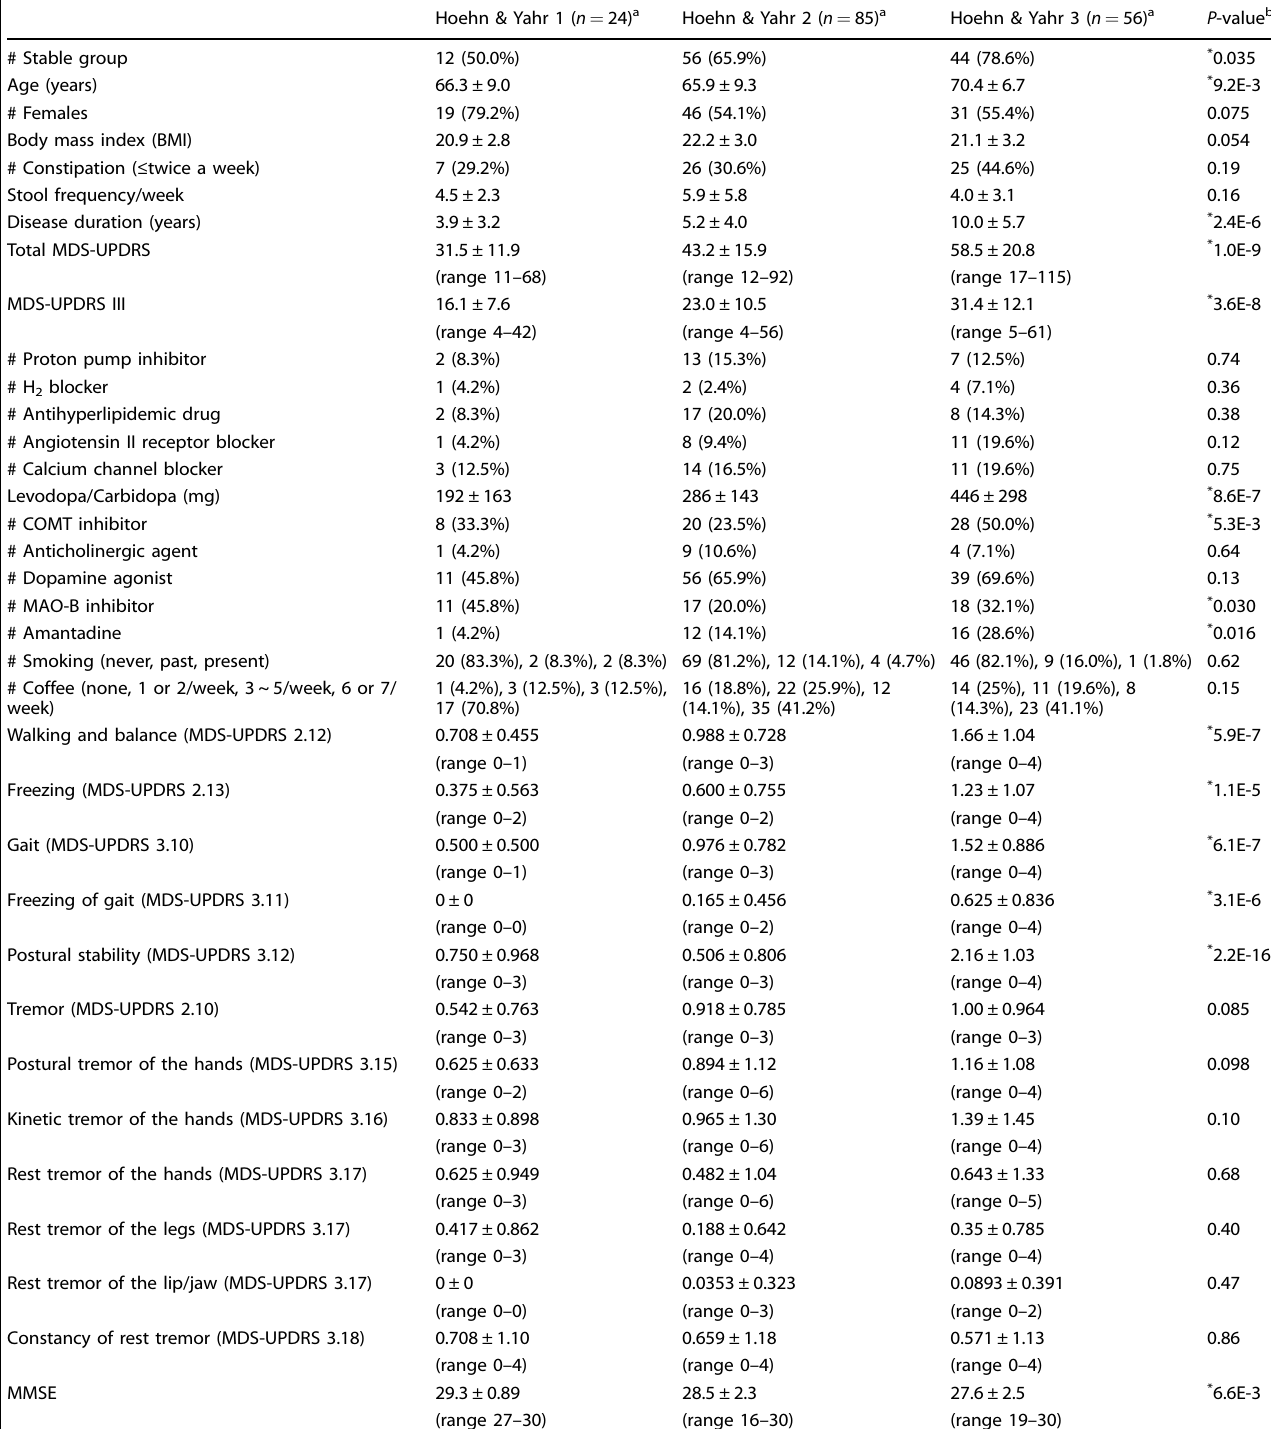
Table 1. Clinical and demographic features of PD patients at Hoehn & Yahr stages 1, 2, and 3 at year 0 used to generate random forest